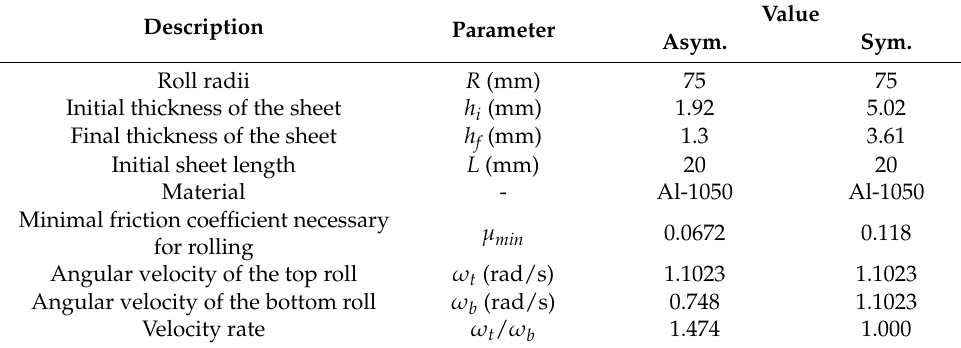
Table 1. Technological parameters used in FEM simulation of cold rolling.